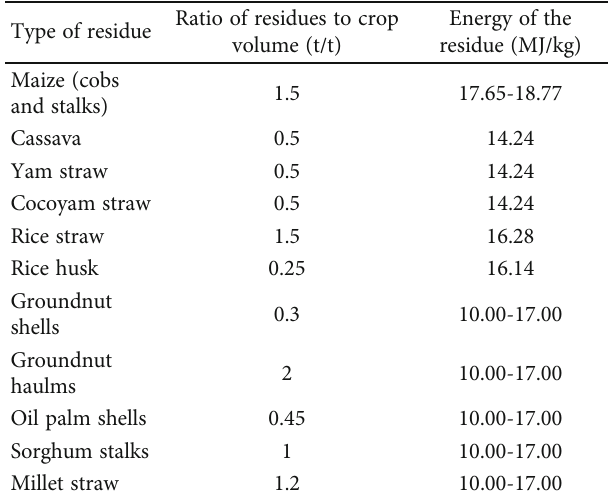
Table 4: “ Residues per unit mass of agricultural produce and their corresponding energy ” [86]. Ratio of residues to crop Energy of the Type of residue volume (t/t) residue